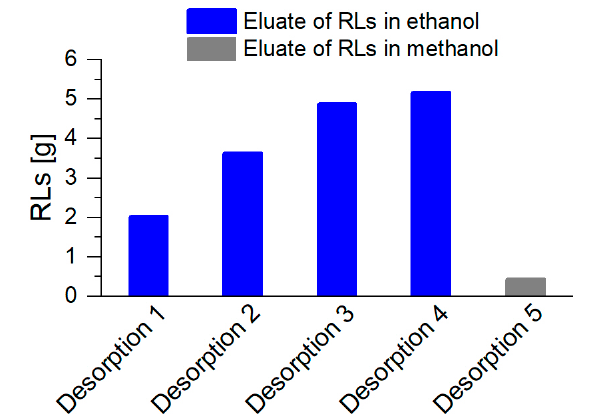
Figure 8. RL harvest after foam adsorption and a subsequent desorption, with ethanol as eluent for the regular elution during cultivation (blue, desorption 1 to 4). Two adsorption columns alternated every 8.5 h, for 34 h, resulting in 4 desorption procedures. Final desorption with methanol was executed at the end of the cultivation (gray, desorption 5).